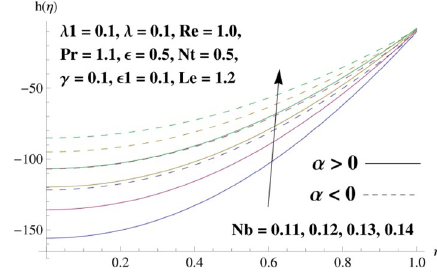
Figure 14. Behavior of h (η) against N b .